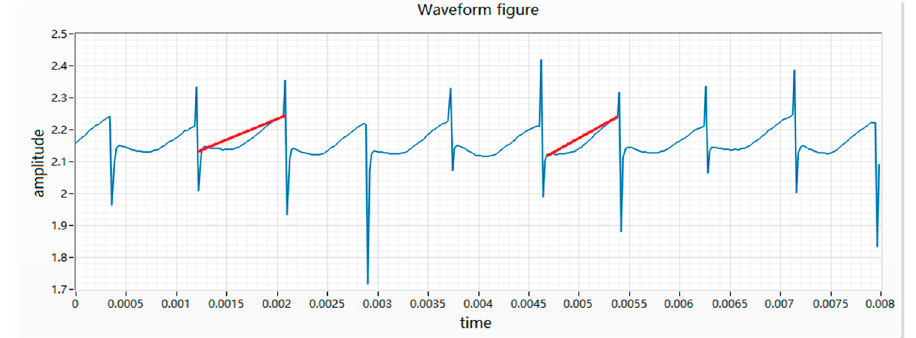
Figure 9. Waveform diagram of a magnetic field fault.